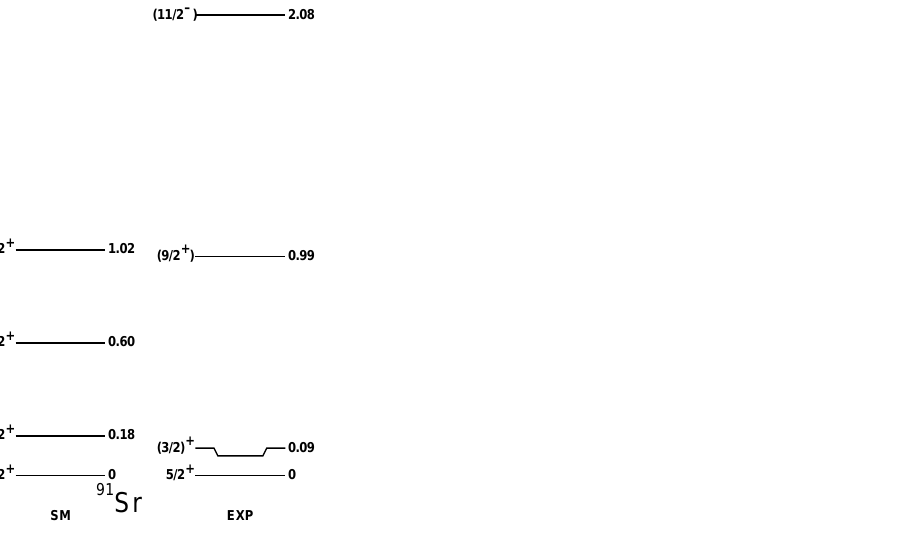
Figure 3. Theoretical low-energy spectra of 91 Sr in comparison to the experimental data from [29].